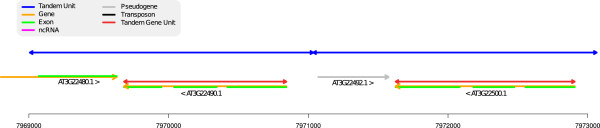
An example of hybrid coding/non coding TA. Region 7,969,000-7,973,000 of chromosome 3. A TA with two TUs. The first detected Tandem Unit covers the 3′ extremity of a coding gene and a complete coding gene. In the second unit, the complete gene is still there, but the 3′ partial gene has apparently lost his function and has been annotated as a pseudo-gene.